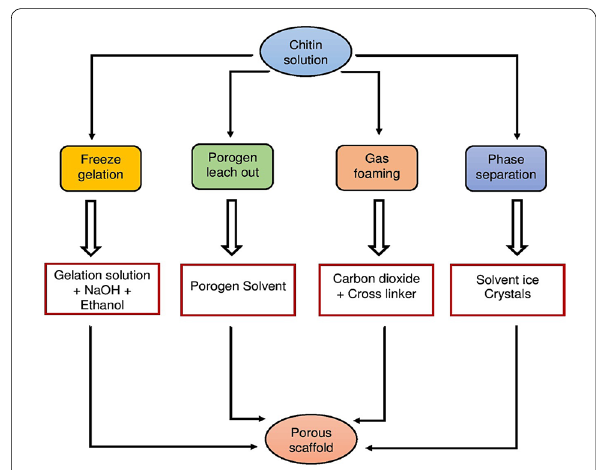
Fig. 9 Methods for scaffold